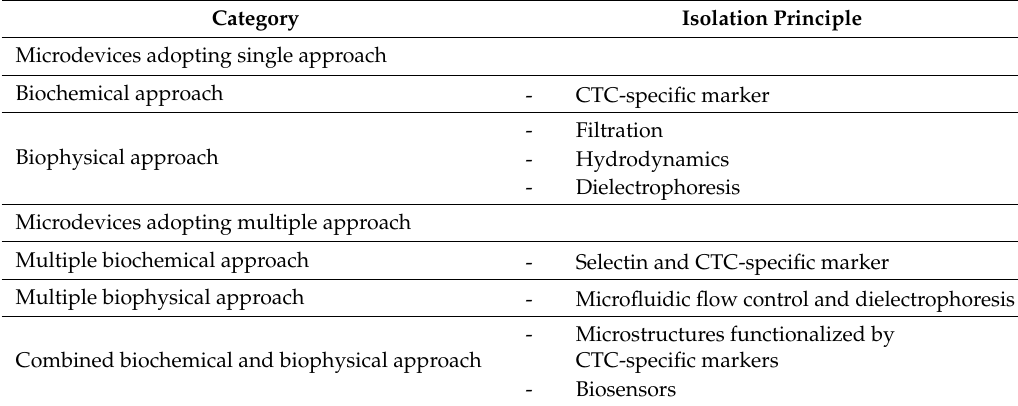
Table 1. Summary of circulating tumor cells (CTC) isolation microdevices.